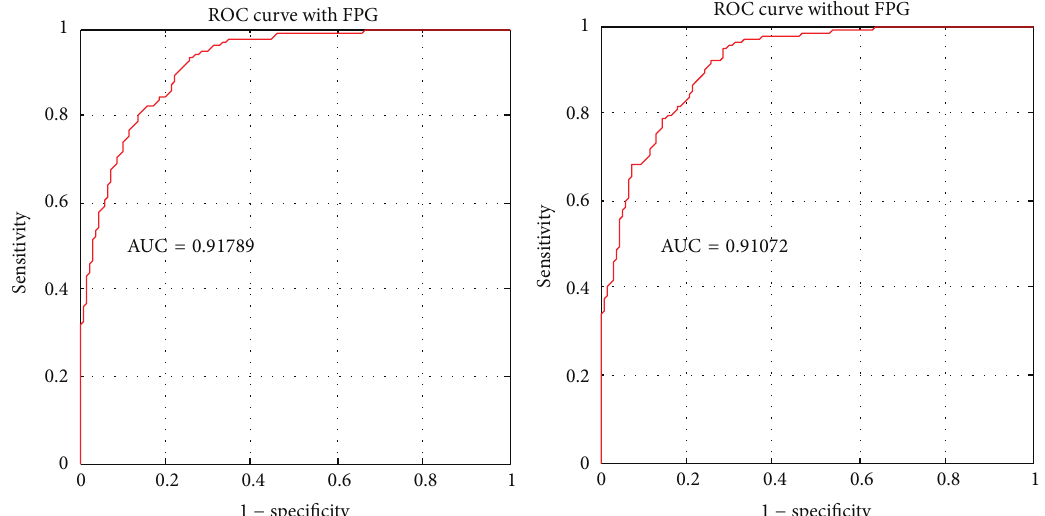
Figure 2: ROC curve of validation result on test set with and without FPG. AUC with FPG is 0.91789 and its standard error is 0.01481. AUC without FPG is 0.91072 and its standard error is